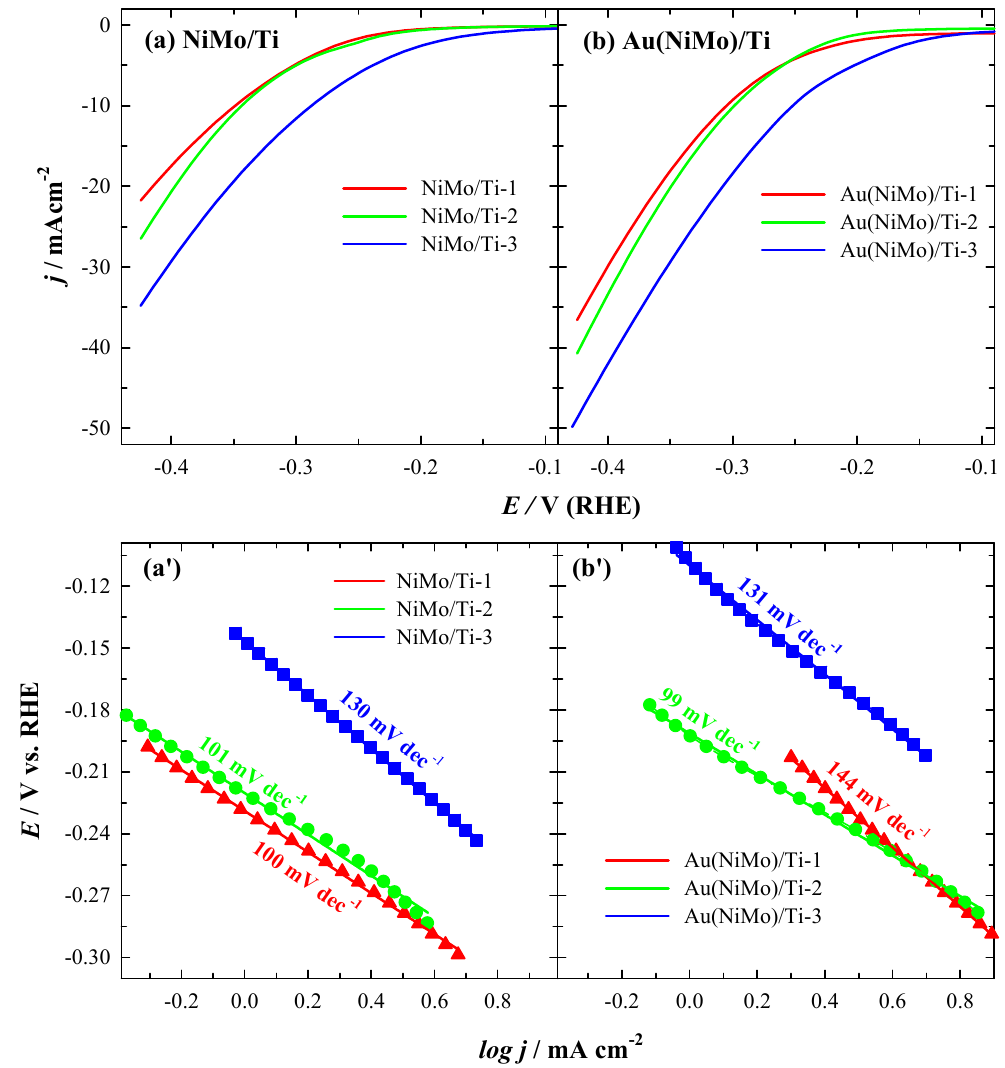
Figure 4 . HER polarization curves of 3D NiMo/Ti ( a ) and Au(NiMo)/Ti ( b ) catalysts in 1 M NaOH solution at a potential scan rate of 10 mV·s − 1 and 25 °C temperature and corresponding Tafel plots ( a’ , b’ ).